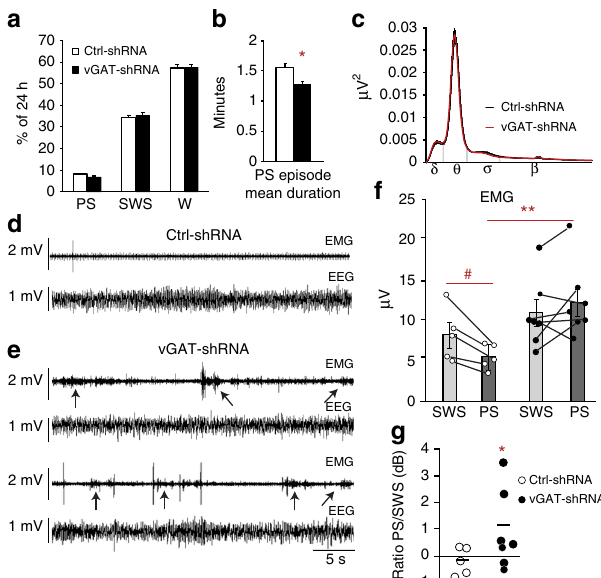
Fig. 4 Loss of muscle atonia during PS after the genetic inactivation of GABA/glycine vmM neurons. a , b Histogram comparing the daily percentages of W, SWS, and PS in Ctrl-shRNA (open bars) vs. vGAT- shRNA ( fi lled bars) rats at day 30 after AAV injections. Notice the signi fi cant reduction of the PS episode duration in vGAT-shRNA vs. Ctrl- shRNA rats ( b ). c Normalized mean power spectrum in a control (black) and experimental (red) rats showing no differences in EEG during PS between both groups. d , e Raw polysomnographic recordings during PS of two representative Ctrl-shRNA ( d ) and vGAT-shRNA rats ( e ) showing the loss, although irregular, of muscle atonia (arrows) concomitant to a strong increase of phasic twitches on nuchal EMG after the genetic inactivation of GABA/glycine vmM neurons. f Dot plots comparing mean EMG values during PS and SWS episodes (bars) in Ctrl-shRNA (open circles) vs. vGAT- shRNA ( fi lled circles) rats. Dashed lines connect SWS with PS mean values for each animal. Control rats show an expected diminution of mean EMG values during PS compared to preceding SWS (i.e., PS atonia). In experimental rats, mean EMG values are comparable during PS and SWS unraveling the loss of atonia during PS. Interestingly, PS EMG is signi fi cantly increased in vGAT-shRNA rats compared to PS EMG in Ctrl-shRNA congeners. g Dot plots represented in decibels showing that PS/SWS ratio of mean EMG values is increased in experimental ( fi lled circles) vs. control (open circles) rats. Mann – Whitney U tests, * p < 0,05 compared to Ctrl- shRNA; Wilcoxon signed rank test # p < 0,05 compared to mean EMG values during